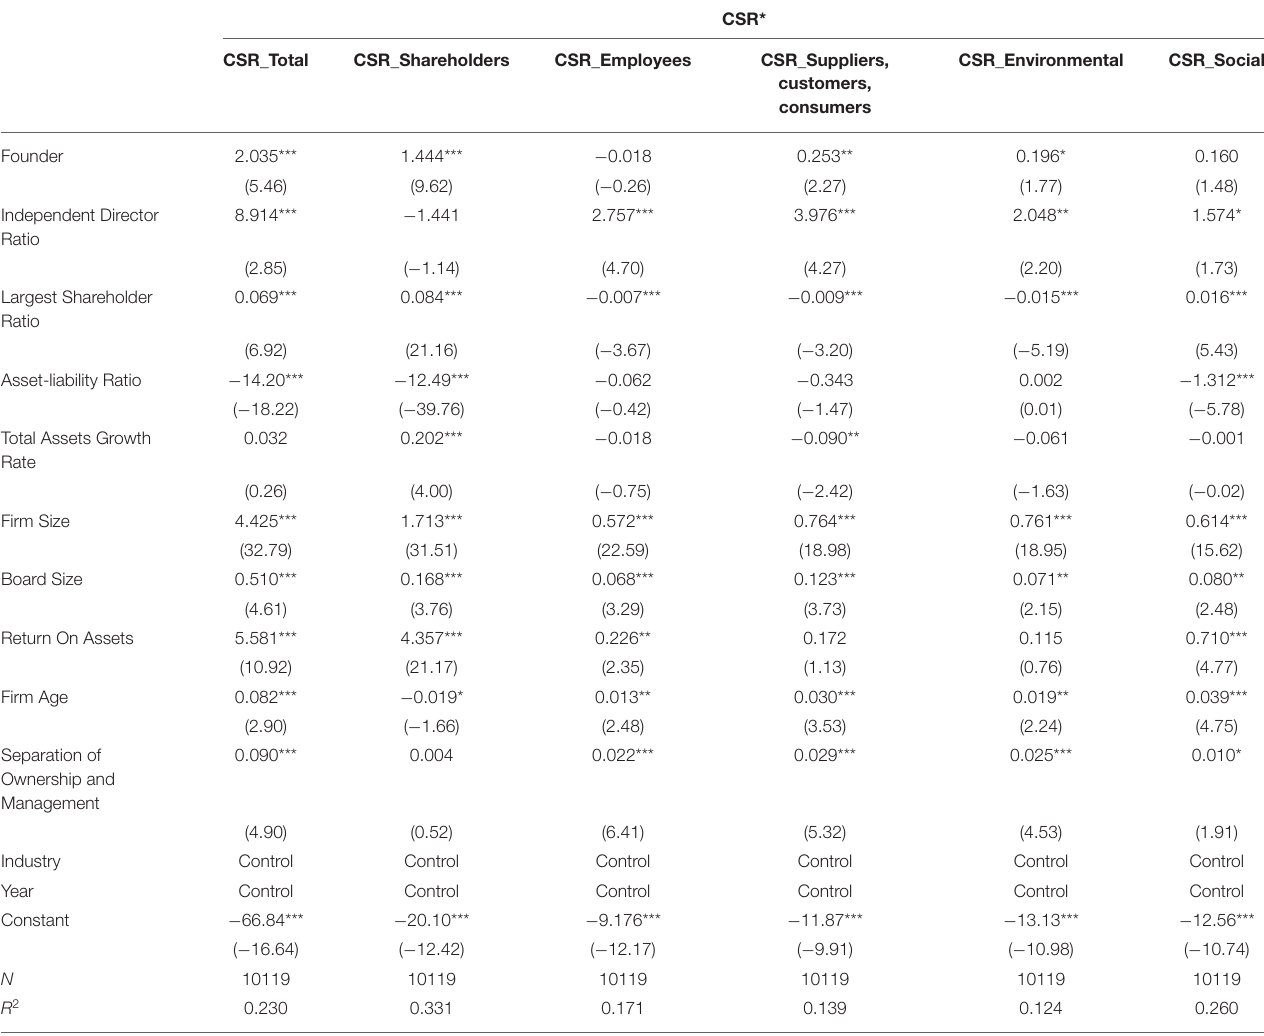
TABLE 7 | Regression results (founder and